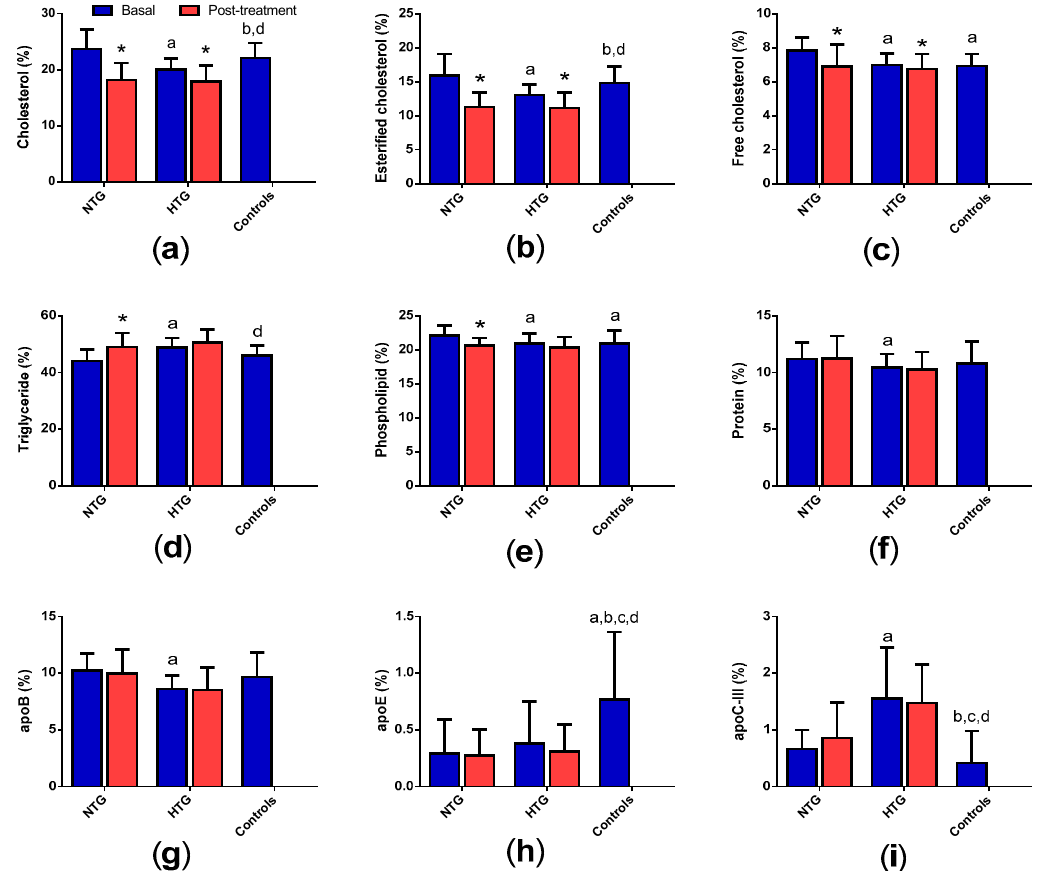
Figure 3. VLDL composition. Data indicate the relative proportion of each component of the VLDL mass and are expressed as mean ± SD. ( a ) total cholesterol, ( b ) esterified cholesterol, ( c ) free cholesterol, ( d ) triglycerides, ( e ) phospholipids, ( f ) total protein, ( g ) apoB, ( h ) apoE, ( i ) apoC-III. * p < 0.05 vs. basal samples. a p < 0.05 vs. basal NTG. b p < 0.05 vs. NTG post-treatment. c p < 0.05 vs. basal HTG. d p < 0.05 vs. HTG post-treatment.